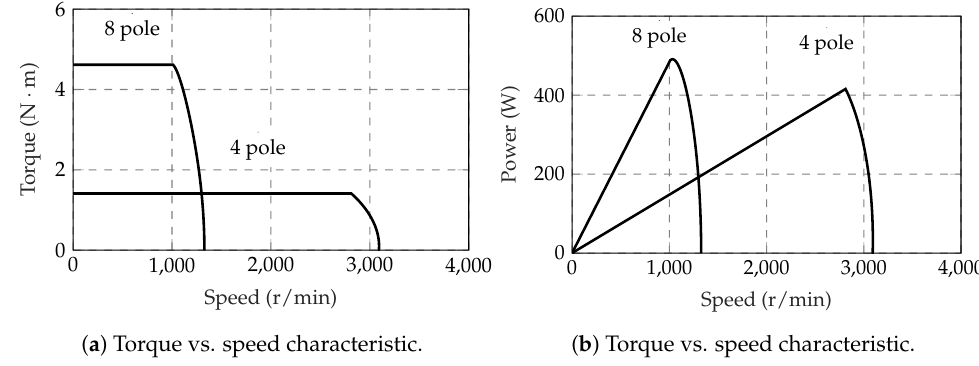
Figure 21. Eight-pole and four-pole HE-IPM torque and power versus speed characteristics.